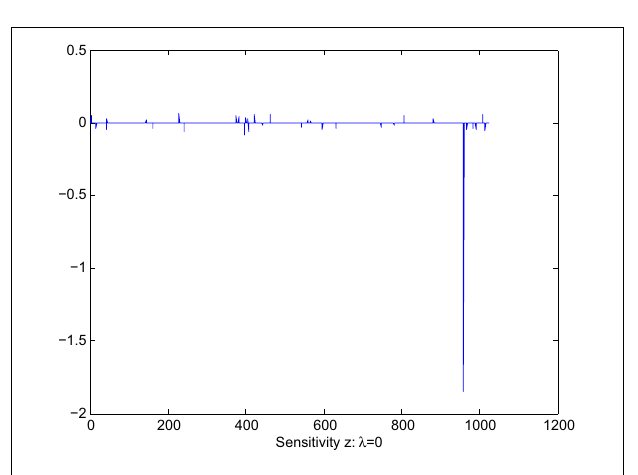
FIGURE 1 | Solution x without sensitivity reduction: (cid:21) = 0 .